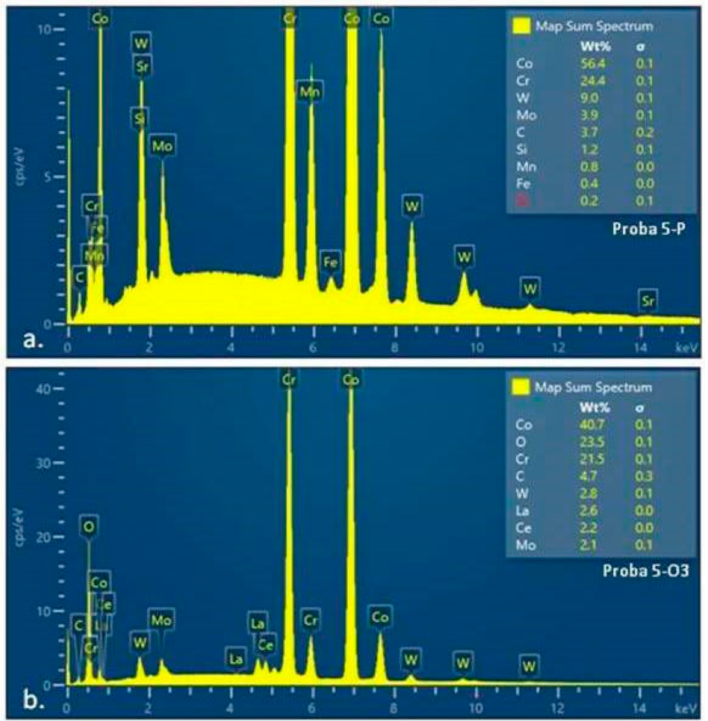
Figure 12. Diagram of EDS spectra with elemental analysis: ( a ) sample 5-P (before heat treatment); ( b ) sample 5-O3 (after heat